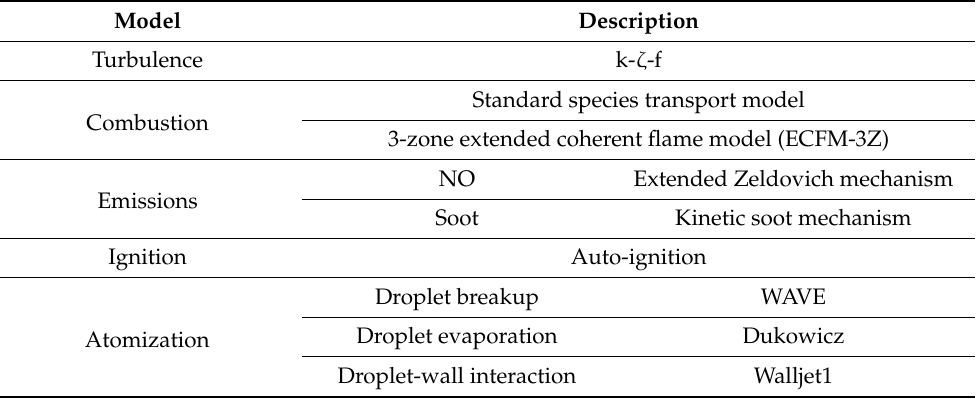
Table 2. CFD models